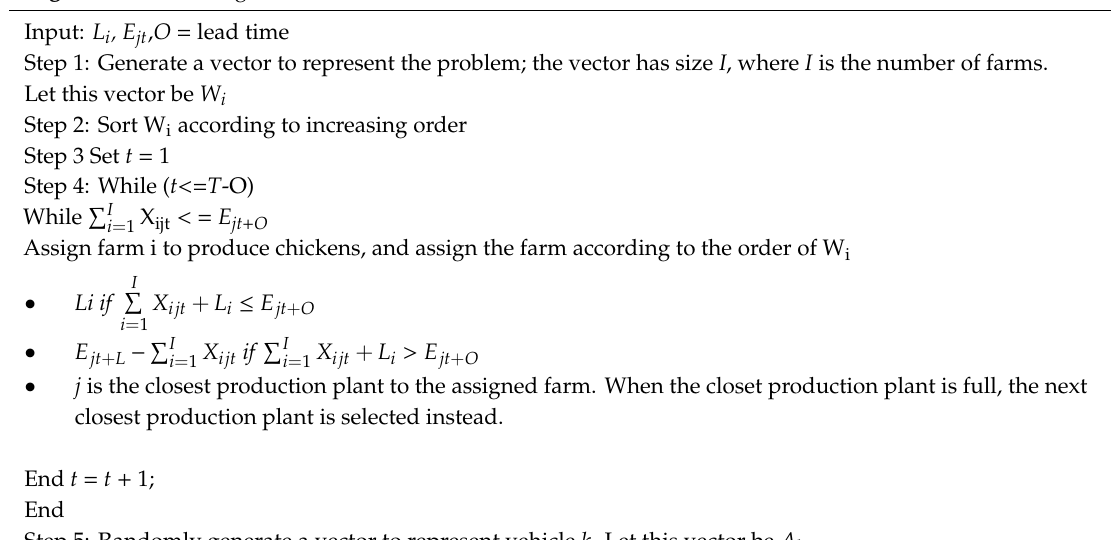
Algorithm 1: Creating the initial solution